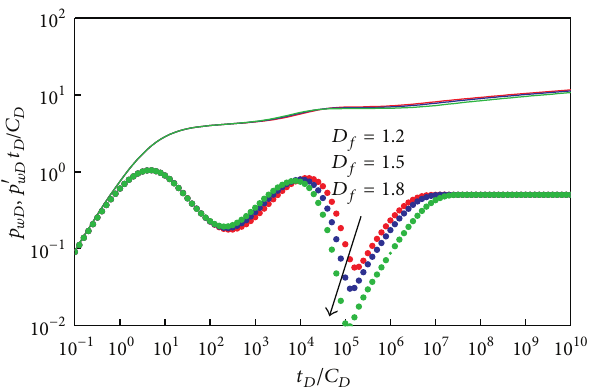
Figure 7: Effect of length ratio ( 𝛼 ) on type curves ( 𝛽 = 0.707 , 𝜃 = 1 , = 10 m, 𝑑 = 0.05 m, 𝑇 = 4 , = 10 m, 𝑑 = 0.05 m, 𝐷 = 1.5 , 𝑇 = 4 , 𝑟 = 𝑁 = 4 , 𝑀 = 10 , 𝑙 0 0 𝑚 0 0 𝑓 𝑚 𝑤 = 2.2×10 −5 MPa −1 , = 0.0001 , ℎ = 10 m, 𝐶 = 2.2 × 10 −5 MPa −1 , and 0.1 m, 𝑆 = −1 , 𝐶 𝑚𝑡 𝐷𝑒 𝑚𝑡 = 1 × 10 −4 MPa −1 ). 𝐶 𝑓𝑡